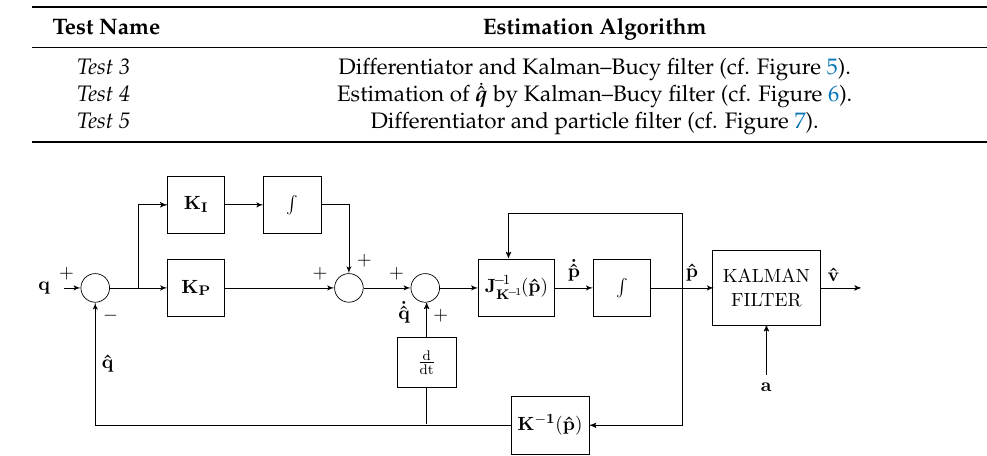
Table 3. Experimental tests for the localization with speed estimation.